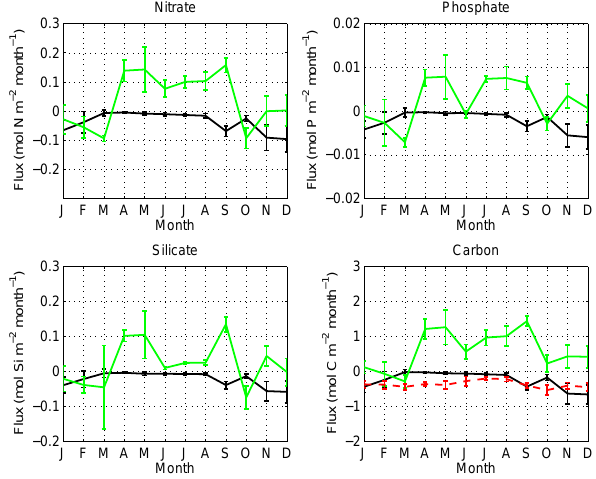
Figure 5. Calculated seasonal fluxes to the upper 100m in the Ice- land Sea, for nitrate, phosphate, silicate and DIC. All fluxes are in molm − 2 month − 1 . The figures show the vertical flux ( F vert ; solid black line), the biological production ( F bio ; green solid line), and the air–sea flux of CO 2 ( F atm ; red dashed line for carbon). The er- ror bars show the propagated errors (see Sect. 6). Note that the scale on the y axis is different for all